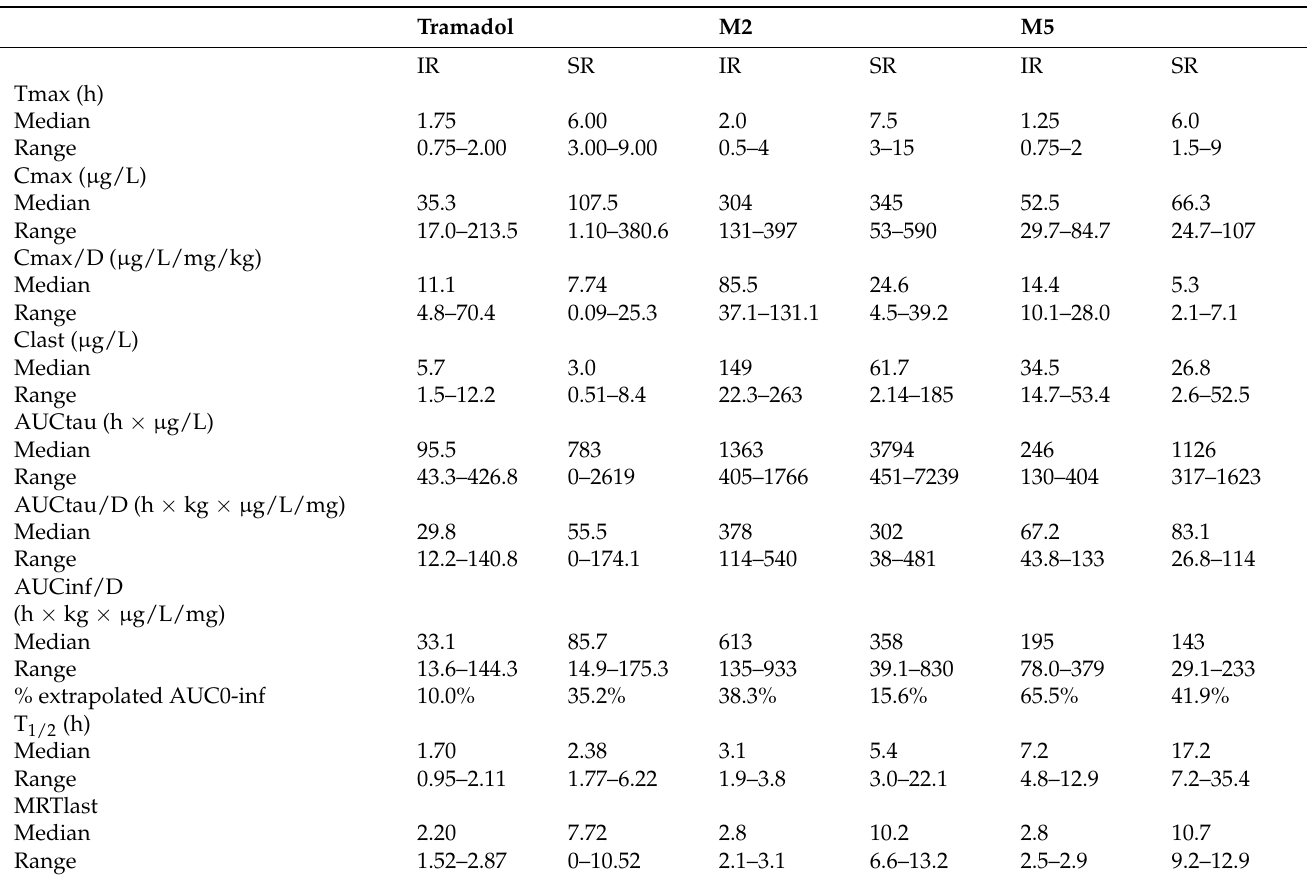
Table 2. Pharmacokinetic values of tramadol, M2 and M5 based on NCA; values below LLOQ are replaced by LLOQ/2 (i.e., 2.5 µ